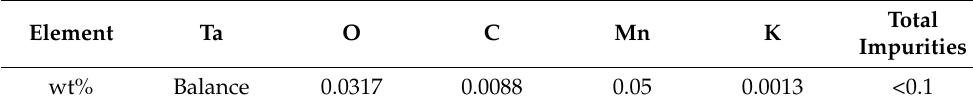
Table 2. Chemical composition of pure tantalum powder materials.